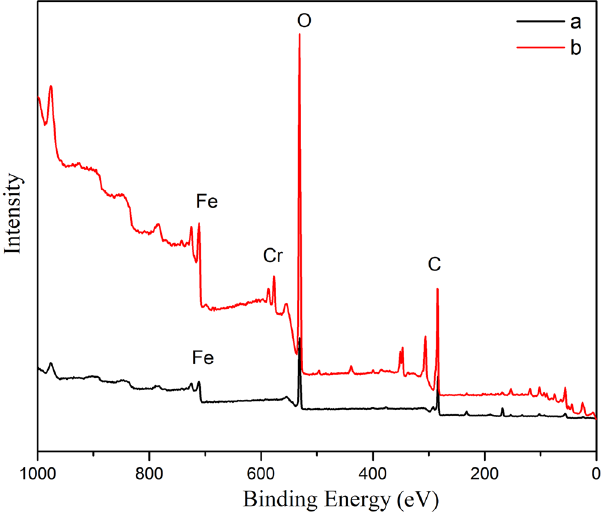
Figure 8. XPS data for the electrode particles (AC-Fe) ( a ) before and ( b ) after the experiment.